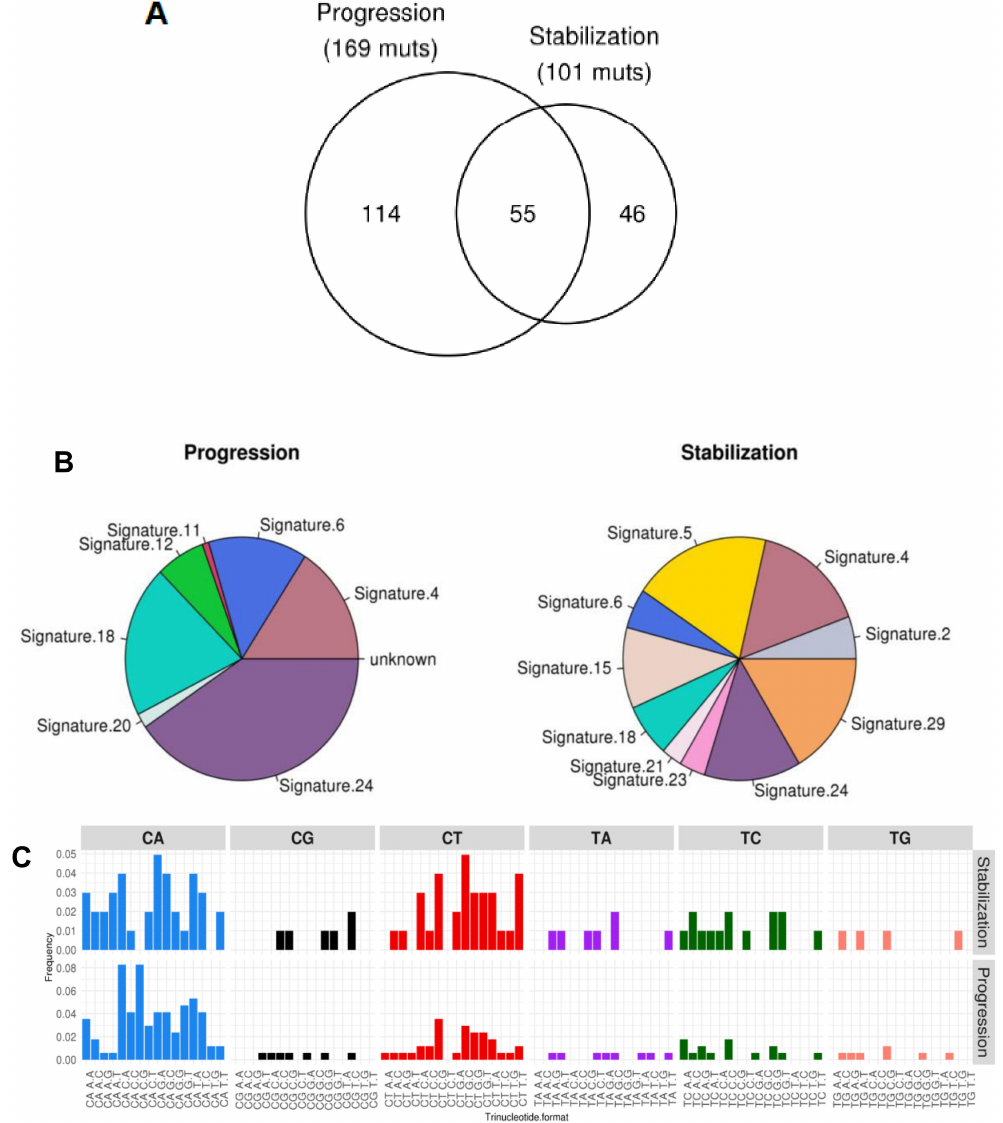
Figure 5. Mutational studies of both tumor samples. ( A ) Total number of mutations was higher during progression. ( B ) Diagrams showing the presence of di ff erent mutational signatures associated to di ff erent types of cancer in both tumor samples. ( C ) Diagrams showing the abundance of each base pair for both tumor samples. This distribution allowed to know the mutational signatures described in